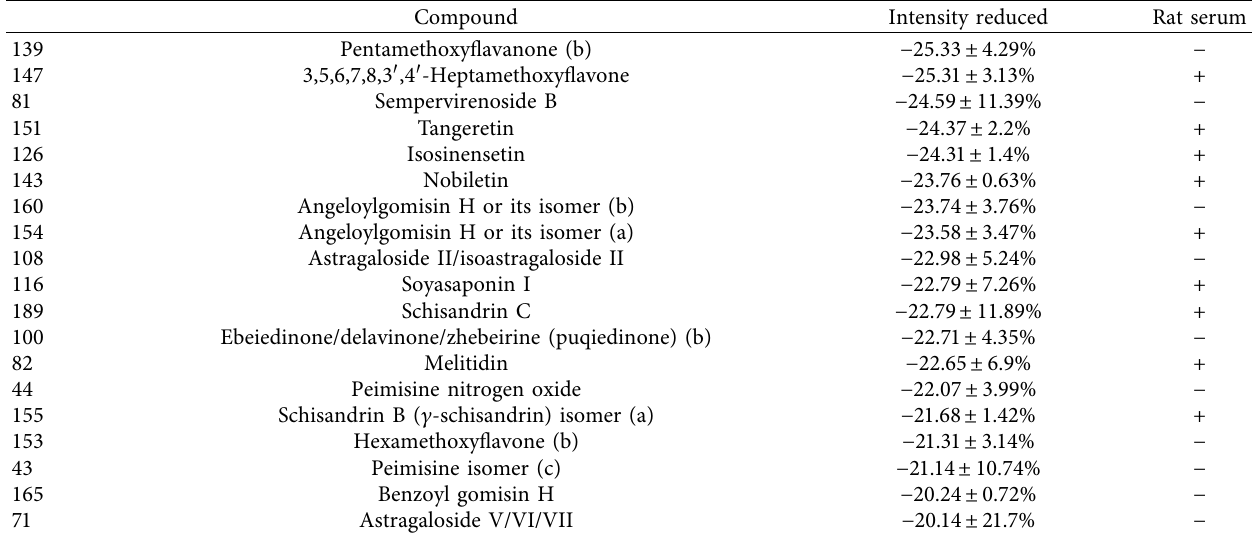
acid. Figure S2. The MS/MS spectra of the reference standard of Pyroglutamic acid. Figure S3. The MS/MS spectra of the reference standard of oxypaeoniflorin. Figure S4. The MS/ MS spectra of the reference standard of loganin. Figure S5. Figure S6. The MS/MS spectra of the reference standard of Hesperidin. Figure S7. The MS/MS spectra of the reference standard of rosmarinic acid. Figure S8. The MS/MS spectra of the reference standard of diosmin. Figure S9. The MS/MS spectra of the reference standard of Peimisine. Figure